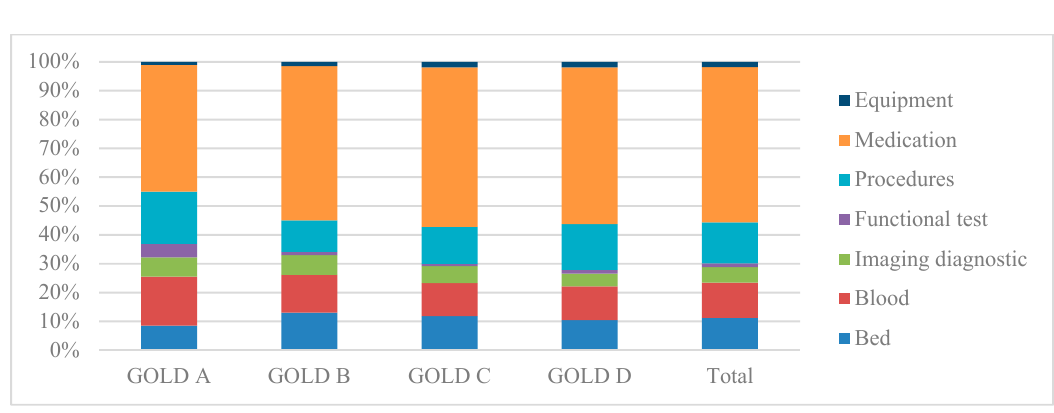
Table 3. Associated factors with AECOPD hospitalization cost. Characteristics